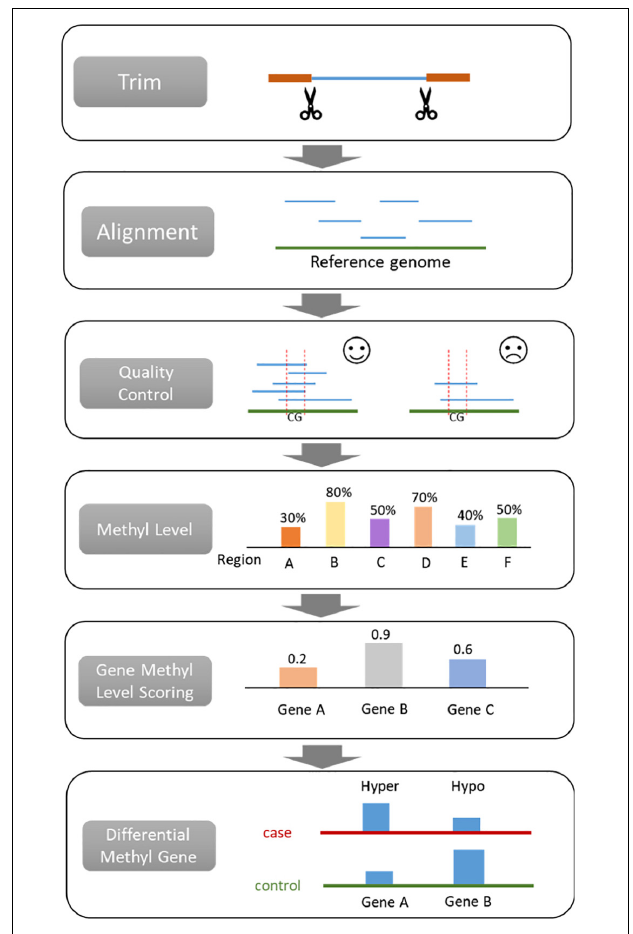
FIGURE 1 | Procedures for analyzing bisulfite sequencing